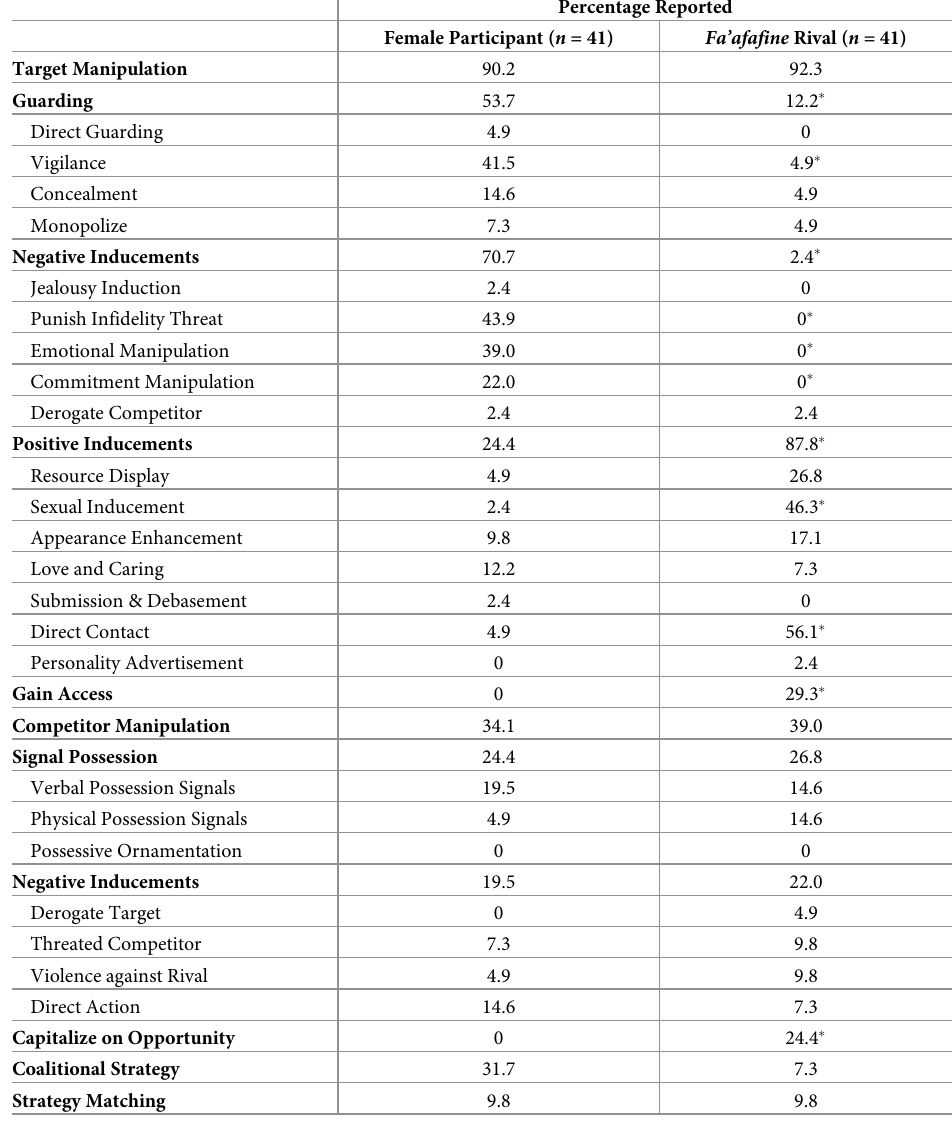
Table 2. Inter-sexual mate competition retention/poaching tactics in